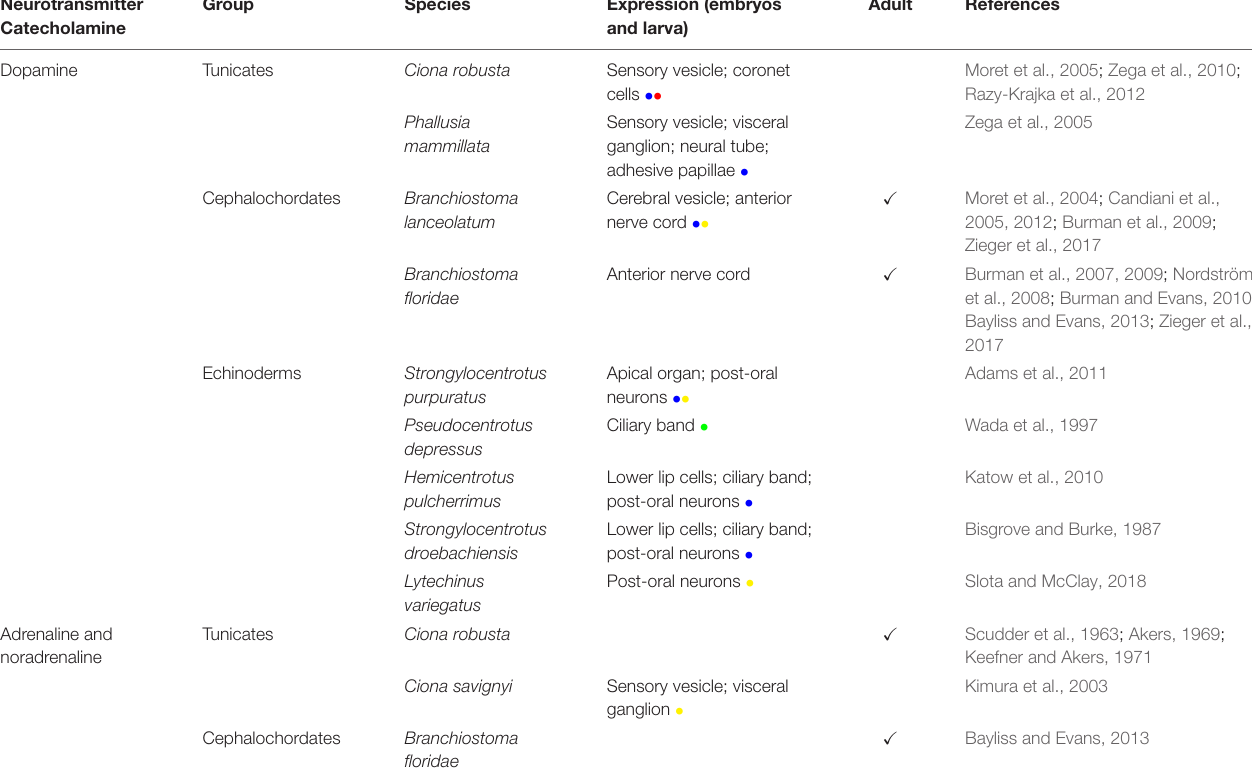
TABLE 1 | Catecholamines: dopamine, adrenaline, noradrenaline distribution in embryos or adult tunicates, cephalochordates, and echinoderms. Neurotransmitter